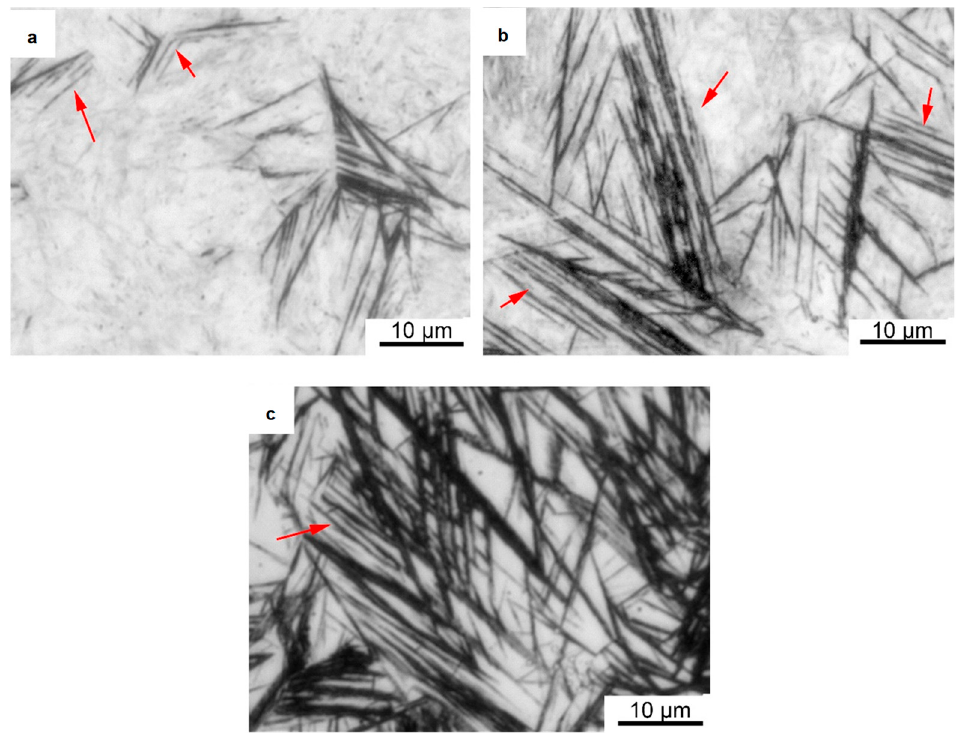
Figure 3. Optical micrographs of samples austempered in molten salt. ( a ) Quenching at 230 °C; ( b ) Quenching at 280 °C; ( c ) Quenching at 320 °C.